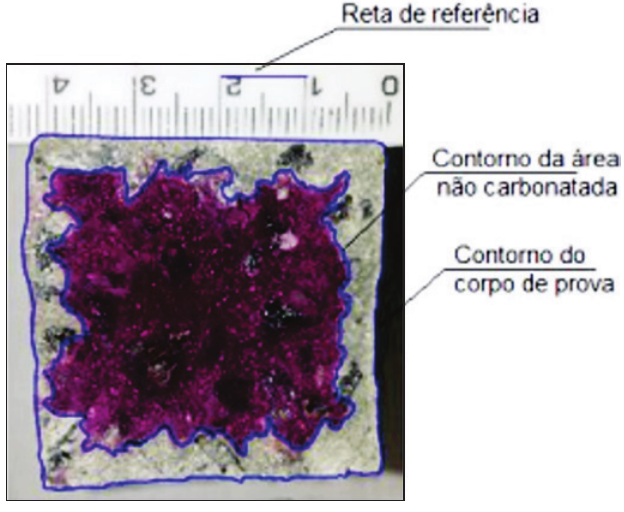
Representação da análise da área carbonatada dos corpos de prova, obtida pelo software Autocad